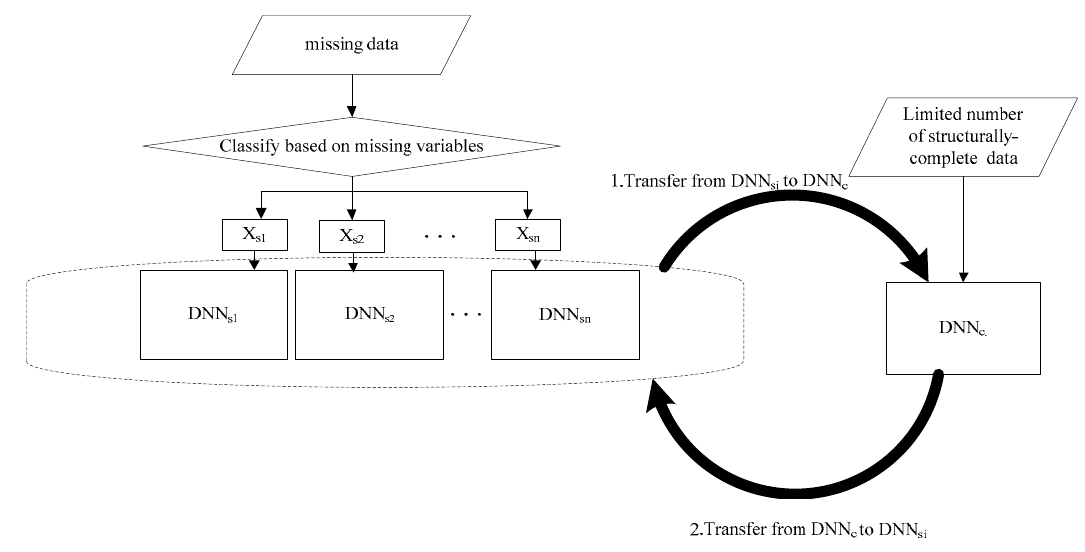
Figure 2. The fault diagnosis framework with missing data.